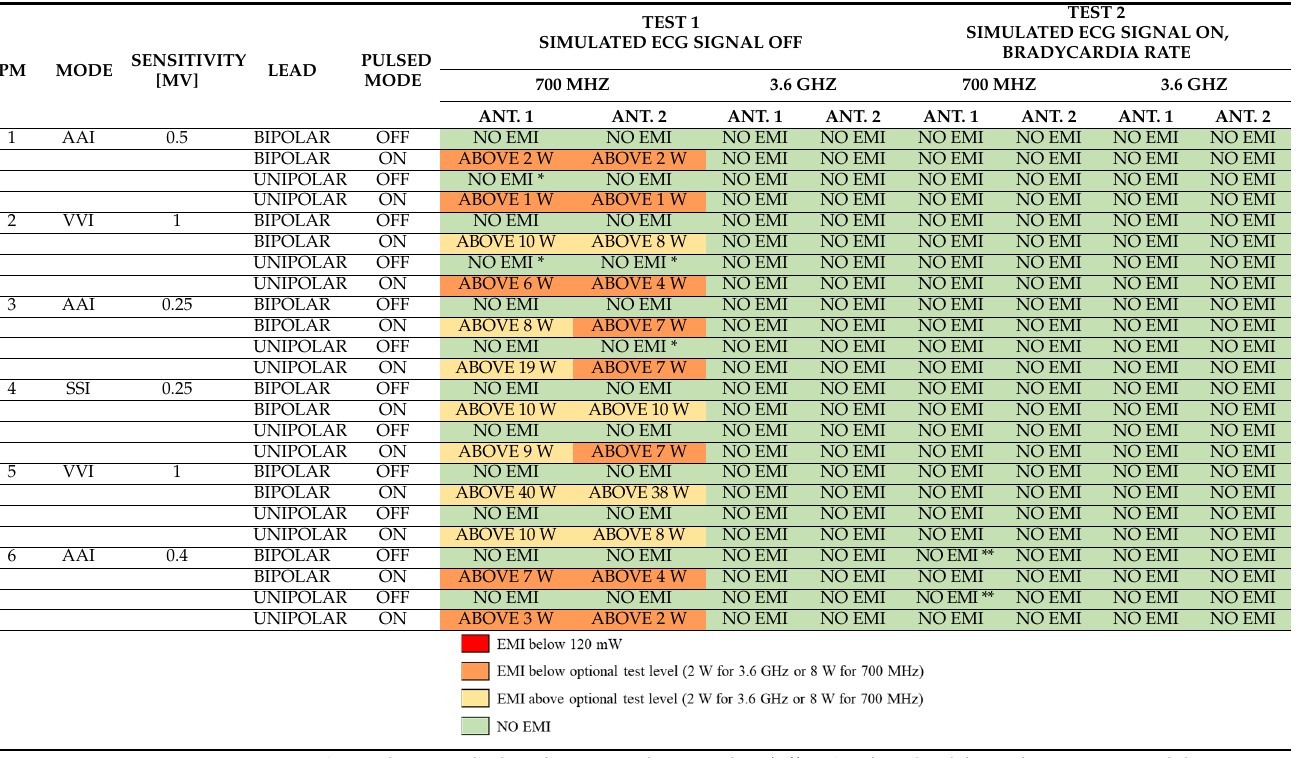
Table 3. PM results, unipolar sensing (power threshold levels are reported rounded to the nearest integer in terms of Watts).